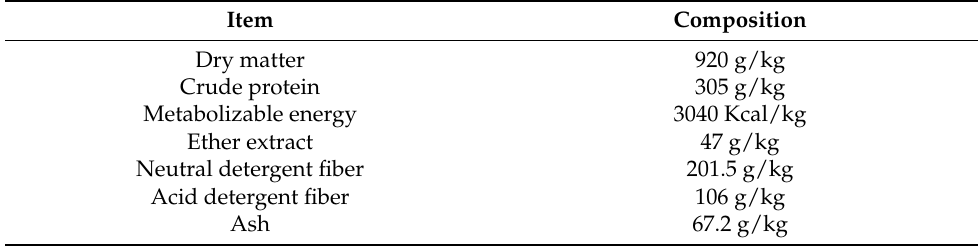
Table 2. Composition of yeast-fermented citrus pulp.